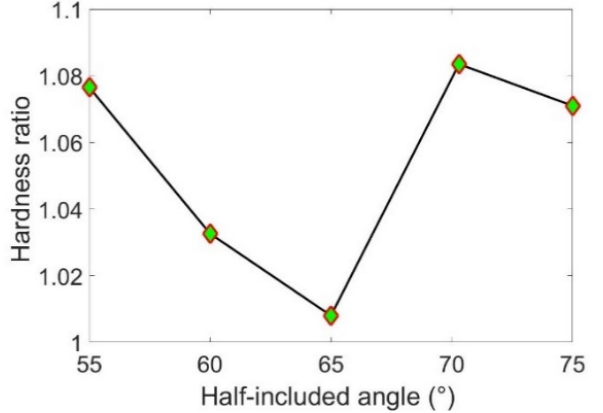
Figure 8. The variation of hardness ratio p